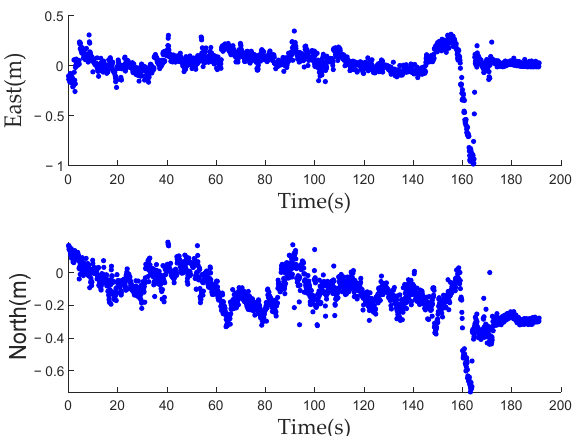
Figure 12. The mean position deviations of the matched targets in the east and north in case one.